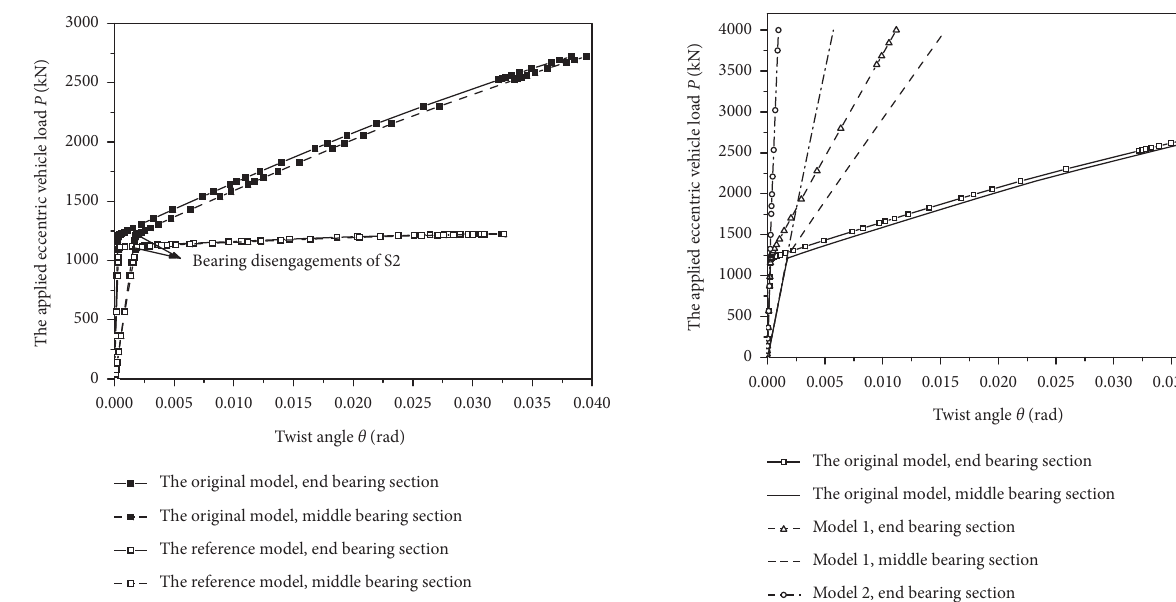
Figure 15: Applied load-twist angle relationships calculated from the original and reference